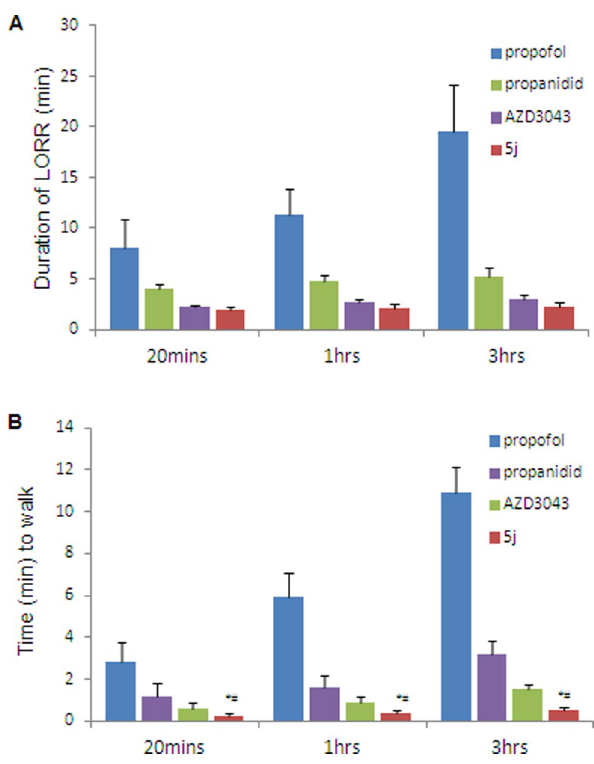
Figure 5. Recovery of propofol, propanidid, AZD3043, 5J in rabbits after a 20-min or 1-h or 3-h IV infusion. (A), Duration of LORR. (B), the time to walk. Induction of hypnosis in rabbits was achieved using 2 6 HD 50 dose of test compound, and immediately after induction, infusion via the tail vein was commenced at half the HD 50 dosage per min. propofol (1.5 mg ? kg 2 1 ? min 2 1 ; n = 4, 4, or 3, respectively), propanidid (2.5 mg ? kg 2 1 ? min 2 1 ; n=5, 4, or 5, respective- ly), AZD3043 (2.4 mg ? kg 2 1 ? min 2 1 ; n=5, 4, or 5, respectively), 5j (3.0 mg ? kg 2 1 ? min 2 1 ; n=5, 4, or 5, respectively) in rabbits. *P , 0.05 compared with propanidid, # P , 0.05 versus AZD3043, a one-way ANOVA with Dunnett’s post hoc test.